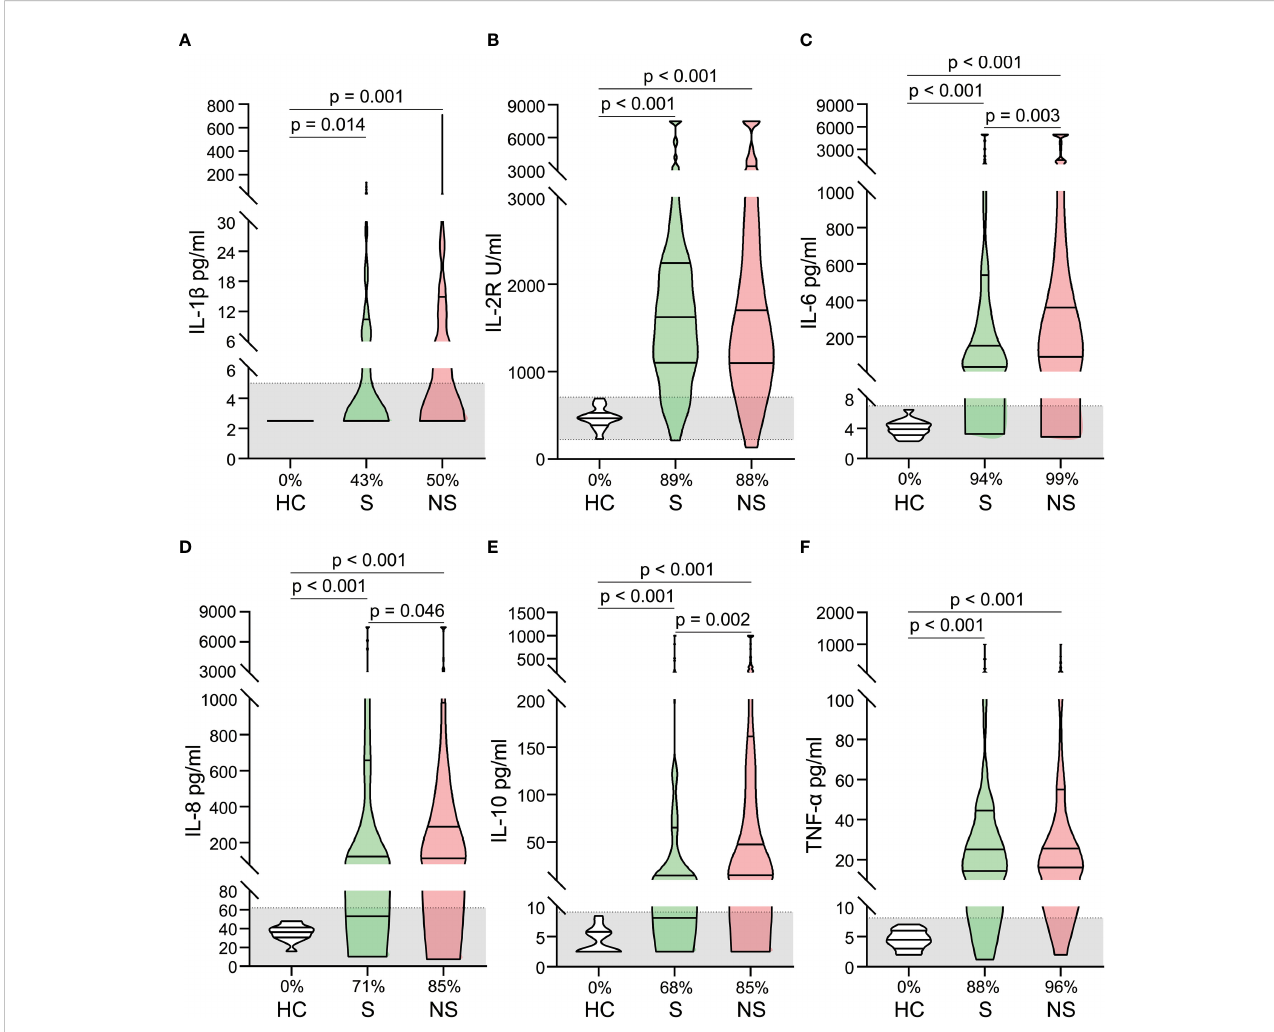
FIGURE 2 Alterations of cytokines in patients with septic shock. The levels of IL-1 b (A) , IL-2R (B) , IL-6 (C) , IL-8 (D) , IL-10 (E) , and TNF- a (F) were compared among healthy controls, survivors, and nonsurvivors. The shaded region represents the normal value range. The proportions of patients whose test results are above the upper limit of the normal range are shown on the x-axis (A – F)